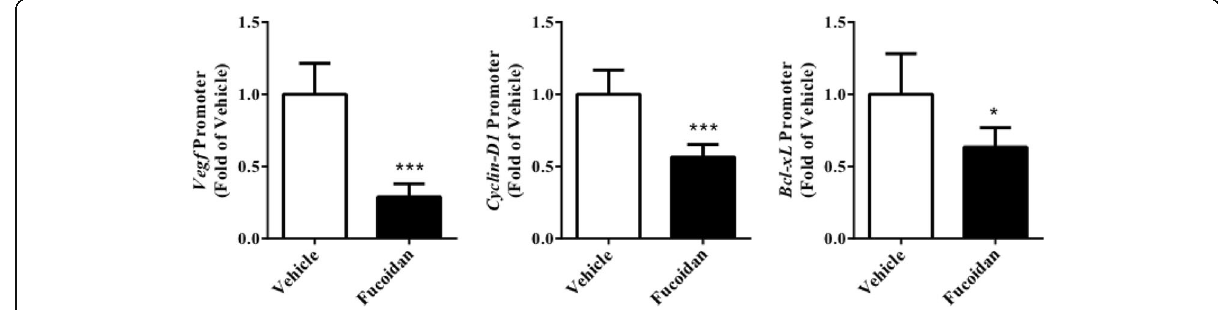
Fig. 6 Fucoidan inhibited activation of STAT3-regulated gene promoters. The nuclear extract in tumor tissue was isolated and used to perform chromatin immunoprecipitation with an STAT3 antibody. The change of downstream promoters was analyzed by real-time PCR. * P < 0.05 vs. vehicle group, *** P < 0.001 vs. vehicle group. N = 6 for each